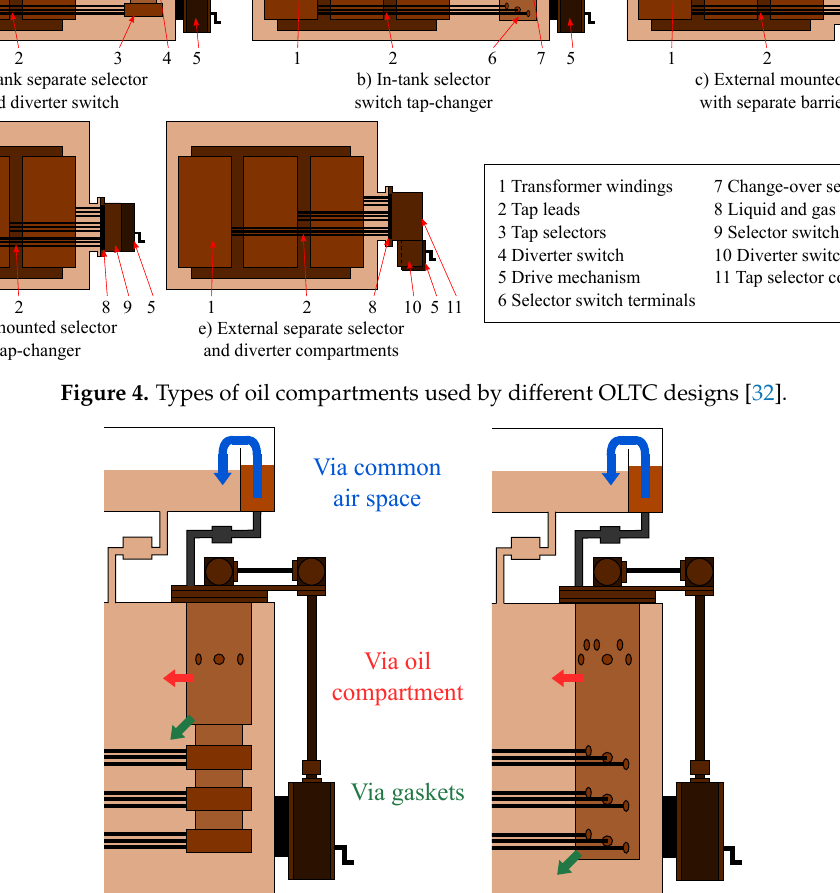
Figure 5. Different pathways for transformer oil contamination from the OLTC gases